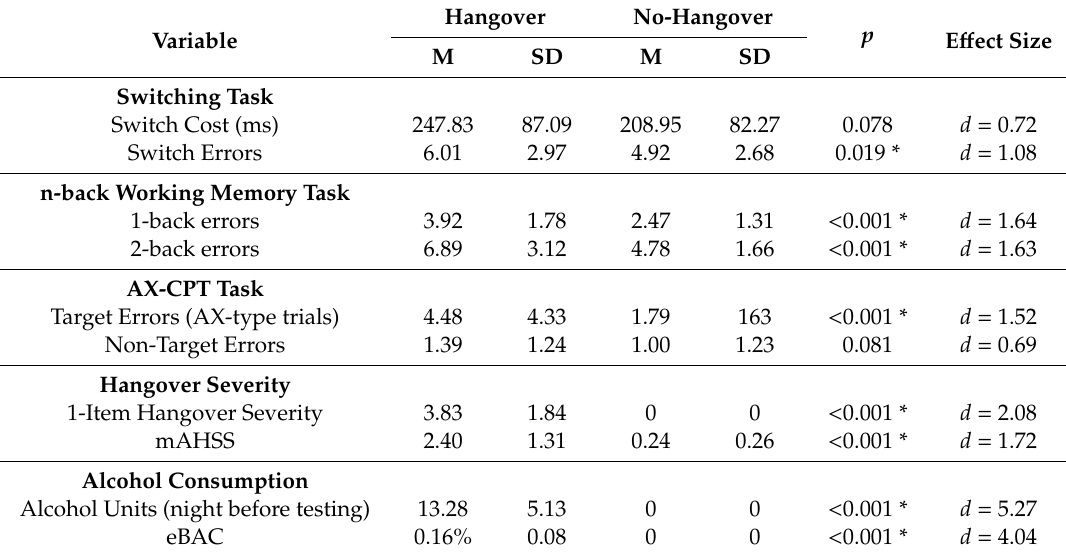
Figure 4. Graphical representations of the condition * order interactions. ( a ) Switching speed decreased (lower switch costs) across testing days when the first testing session was the hangover condition, but not when the first testing session was the no-hangover condition. ( b ) Switching accuracy declined (greater number of non-perseveration errors) across testing days when the first testing session was the no-hangover condition, but not when the first testing session was the hangover condition. ( c ) Updating performance improved (fewer errors) across the testing days for those completing the hangover condition first, but not for those completing the no-hangover condition first. The error bars represent ± 1 standard error of the mean. Table 1. Means, standard deviations, and group comparisons for each variable.